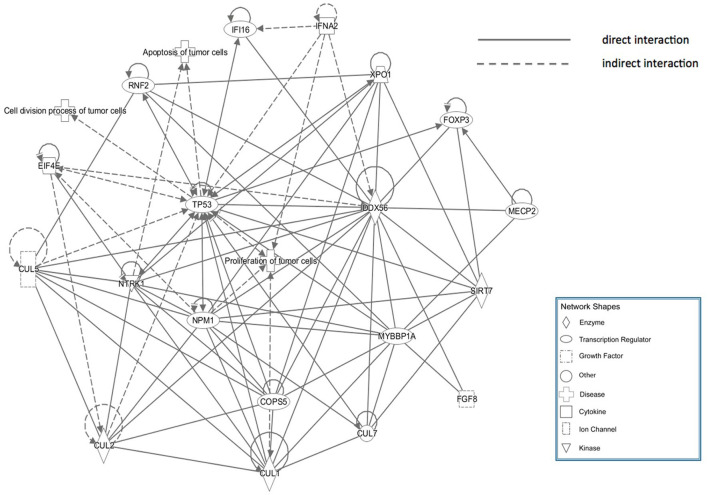
Ingenuity Pathway Analysis (IPA) network of genes that directly interact with DDX56, which were enriched in cell proliferation, apoptosis, and cell cycling.